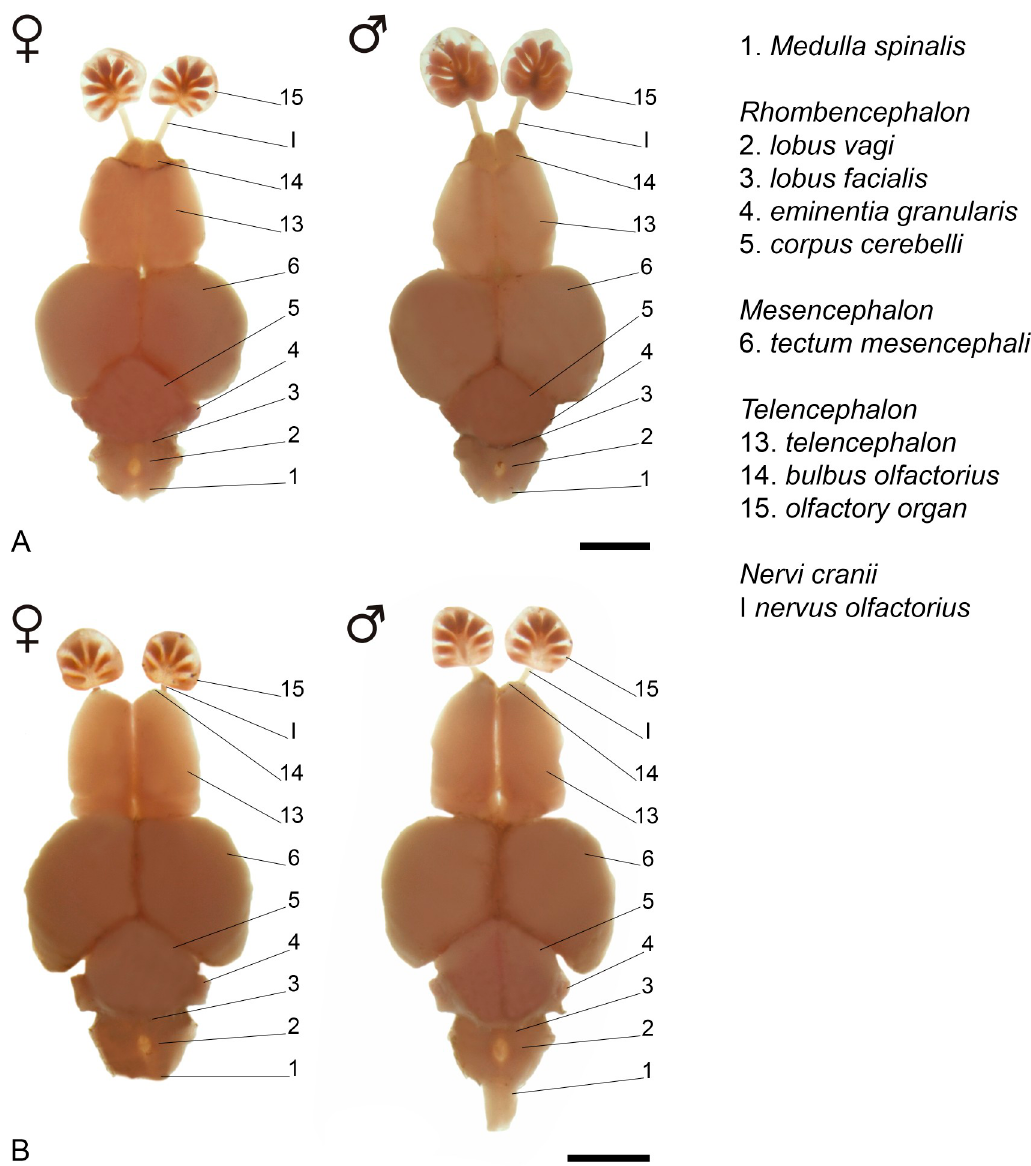
Fig 10. Gross brain morphology of Tyttobrycon species. (A) Tyttobrycon marajoara MZUSP 106110, paratypes, mature specimens; female, 19.0 mm SL; male, 18.1 mm SL. (B) Tyttobrycon dorsimaculatus MZUSP 89943, mature specimens; female, 17.7 mm SL; male, 17.6 mm SL. Dorsal view. Scale bar 1 mm.